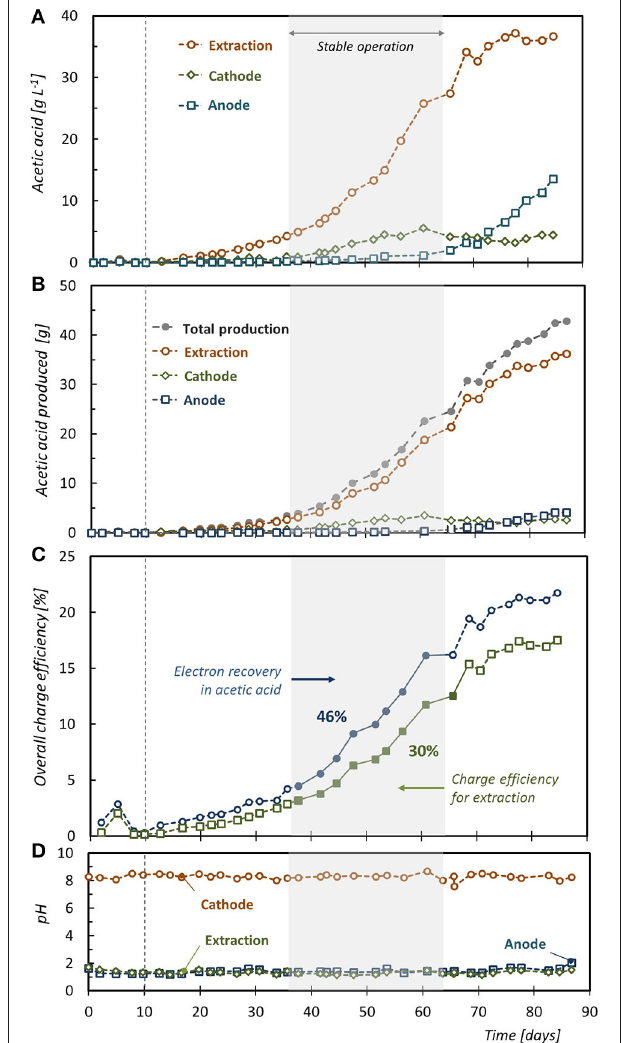
FIGURE 2 | (A) Acetic acid concentration in the catholyte, middle compartment and anolyte. (B) Total mass of acetic acid produced, extracted across the AEM and present in the extraction liquid. (C) Overall charge efficiency for production and extration. (D) pH in the different reactor chambers. Dotted vertical lines represent the start of gas